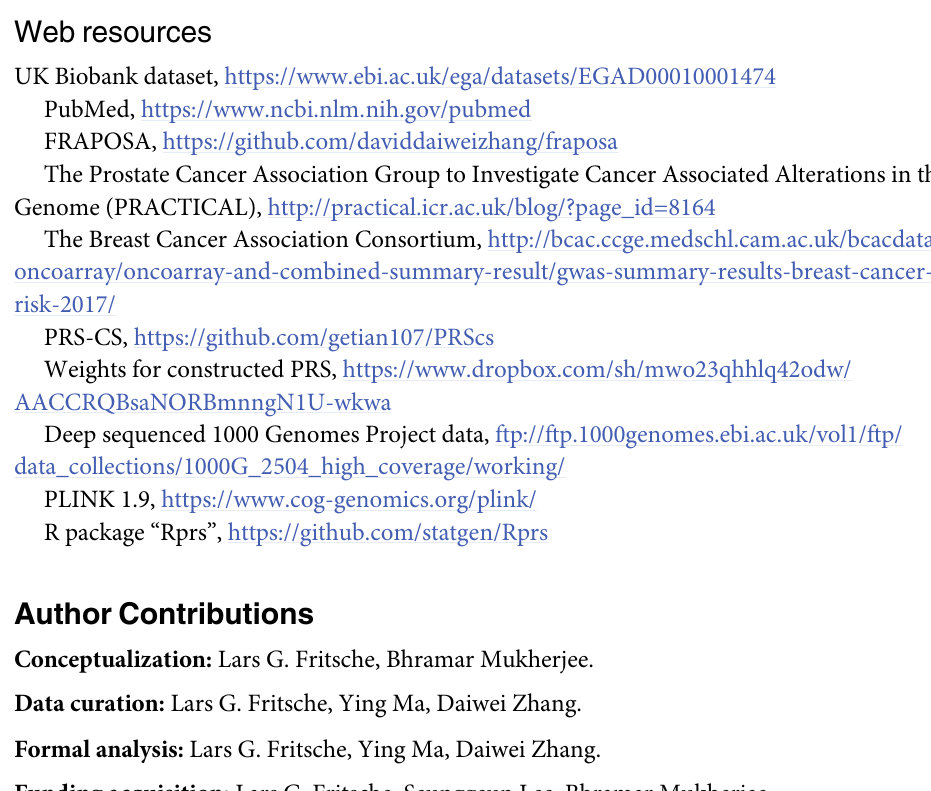
S10 Table. Influence of Case-Control ratios on case enrichment in prostate cancer